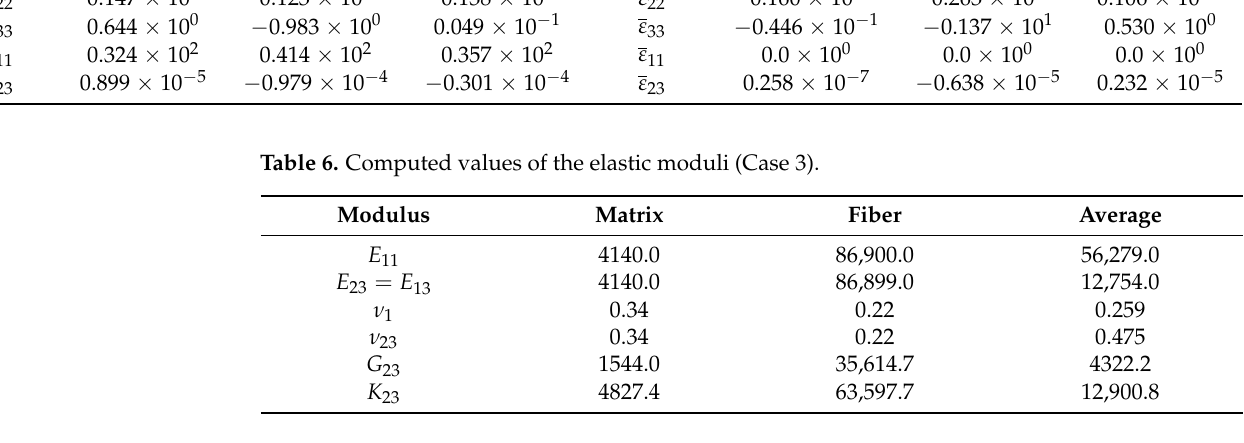
Table 7. Finite element models and associated boundary conditions